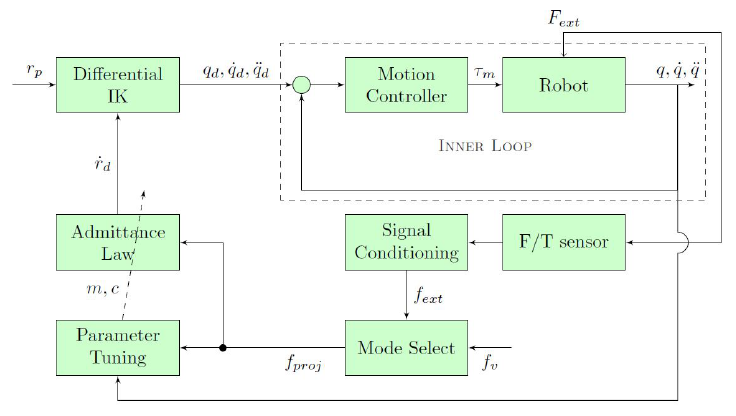
Figure 2. Block diagram of adaptive admittance control with path